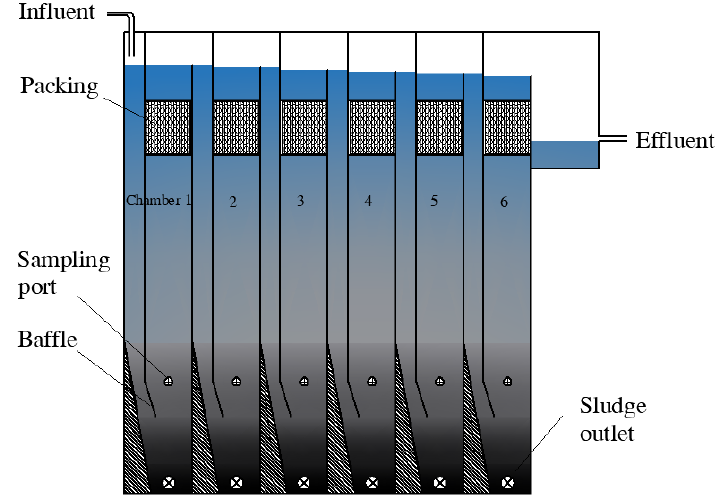
Figure 1. Schematic diagram of the anaerobic baffled reactor with packing in this study.